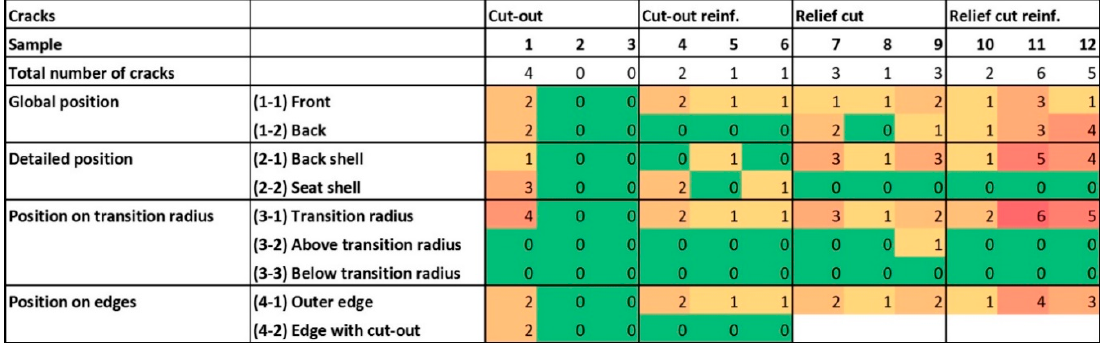
Figure 6. Heat map of crack number and position.